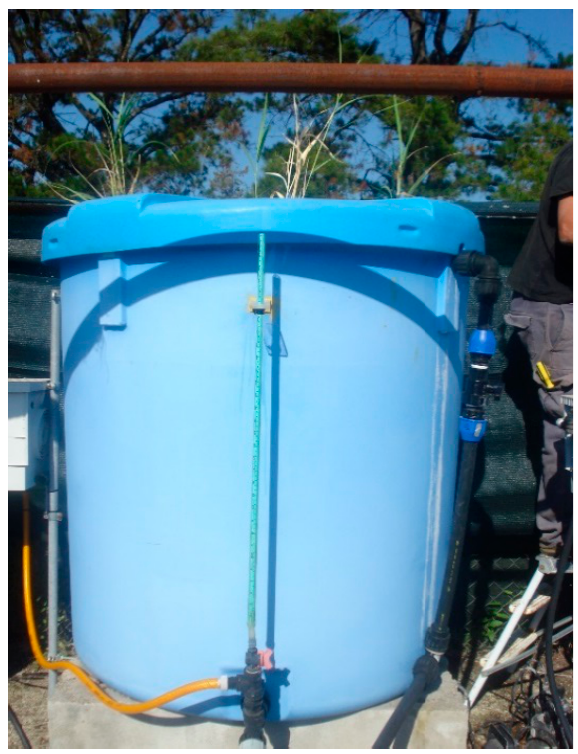
Figure 1. Mesocosm used for growing the Arundo plants.